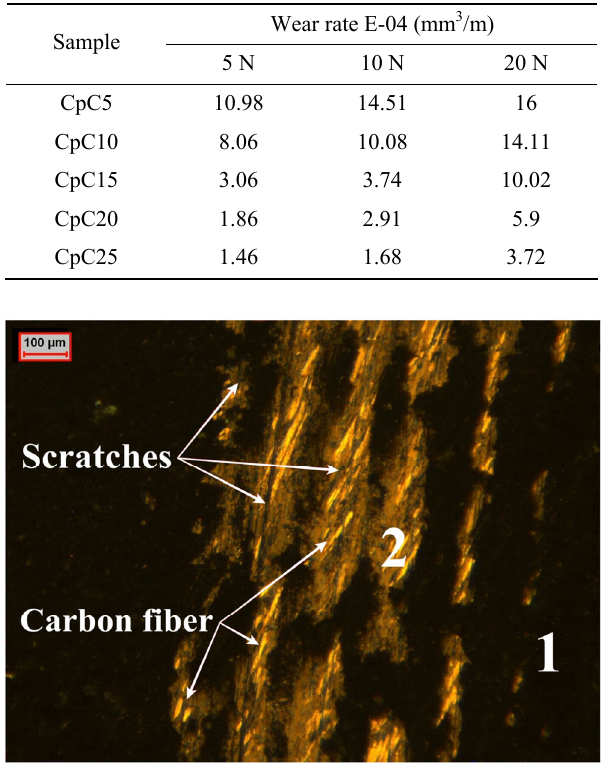
Fig. 7 Wear rates of various composites. Fig. 8 Polarized light optical micrograph of sample